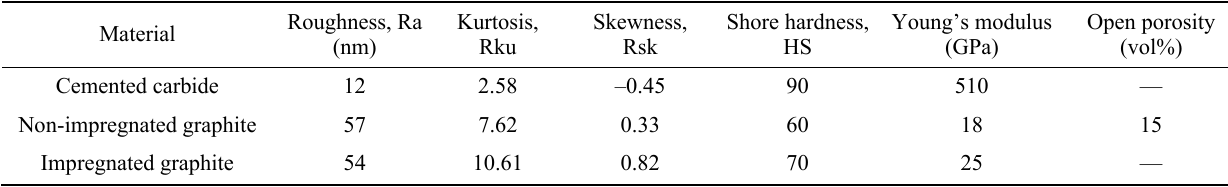
Table 1 Mechanical and physical parameters of test materials. Material